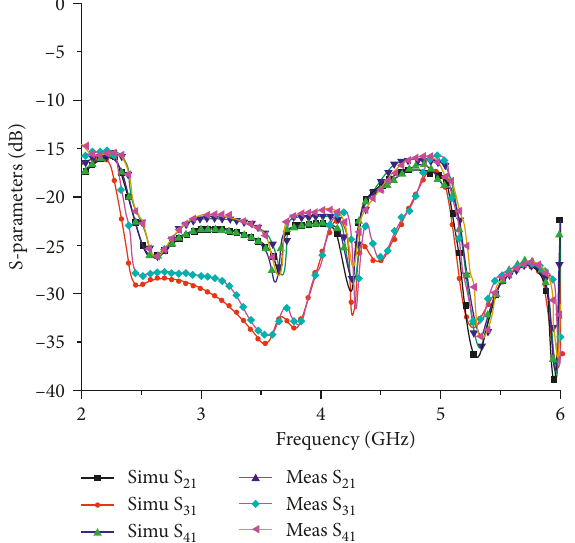
Figure 7: Simulated and measured reflection coefficients of the proposed antenna.